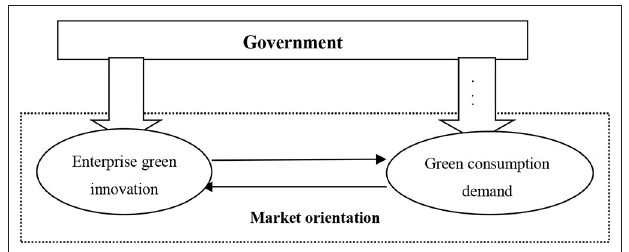
FIGURE 1 | The relationships among the government, enterprises and consumers under market orientation.